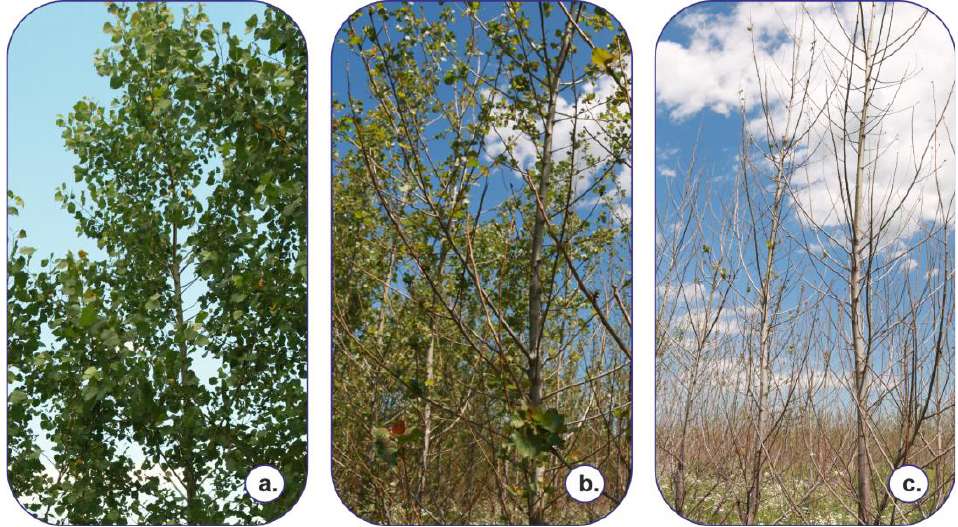
Figure 2. Poplar trees affected by different degrees of defoliation (( a ) — non-defoliated; ( b ) — partially defoliated; ( c ) — completely defoliated).